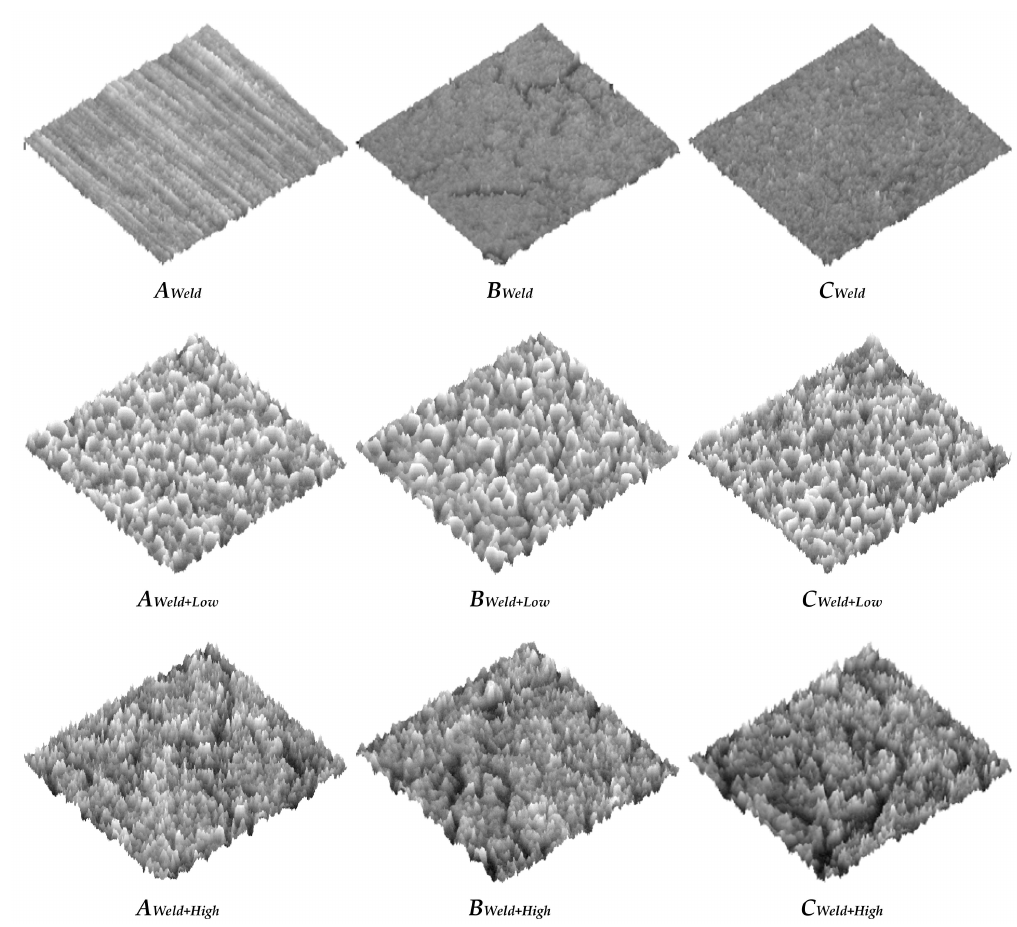
Figure 13. Surface topography images for three samples with three regions each, Image size = 0.8 mm 2 . Further image analysis was performed to find the distribution of dimple size in each of the shot-peened ROIs. These results are shown in Figure 14. The number of dimples was counted for a size range from 20 to 150 micrometers. This was achieved by running a matched filter with a variable-diameter disk as a filter mask. The analysis shows that the low-intensity shot-peened ROIs (top row) do not contain dimples larger than 100 micrometers, whereas the high-intensity shot-peened samples do. Within the sample, using row-wise inspection, it is evident that the heat-affected zones in B Weld+Low and B Weld+High have the most dimples of 100-micrometer